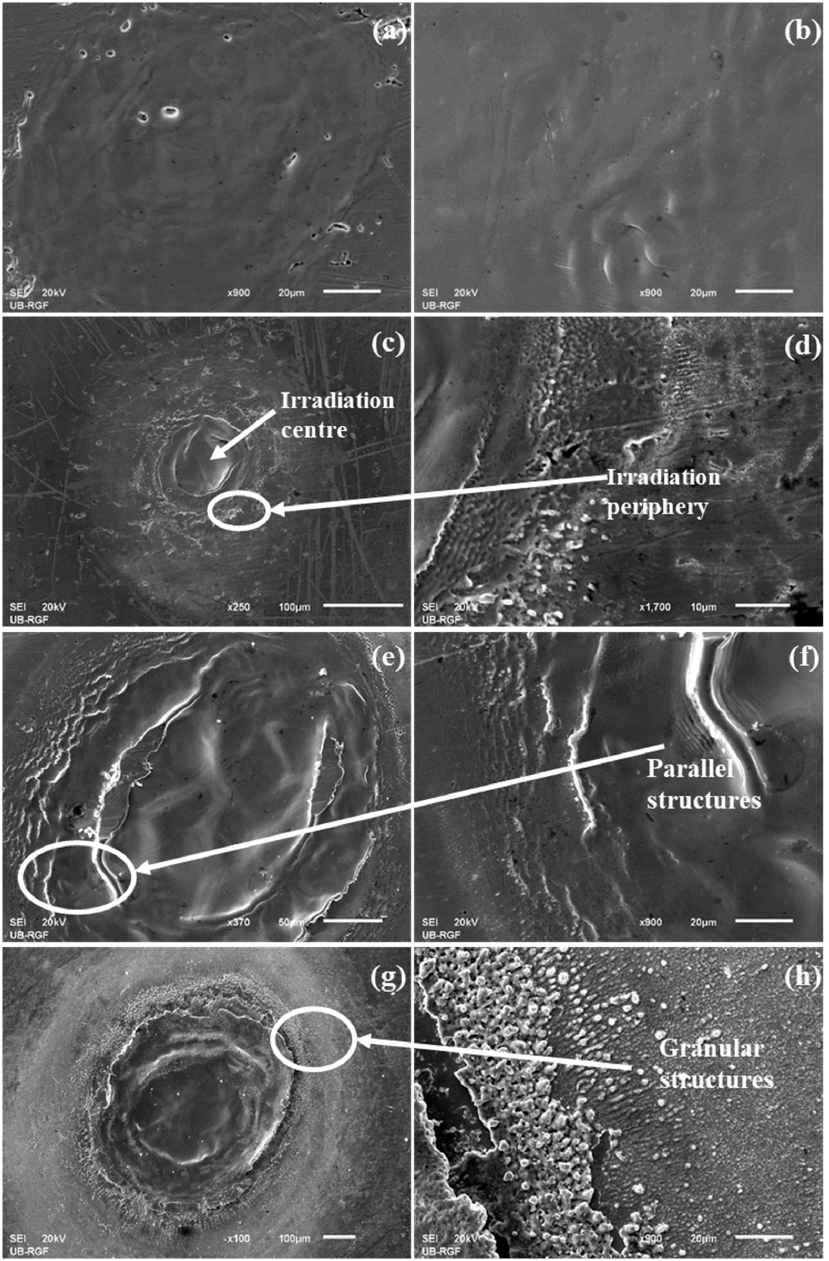
Figure 1. SEM microphotographs of Nimonic 263 superalloy surface after the irradiation by pico- second Nd:YAG laser, wavelength 1064 nm, pulse duration 150 ps: ( a ) whole spot and ( b ) periphery, N p = 10, F = 5.50 J cm − 2 , SA conditions; ( c ) whole spot and ( d ) periphery, N p = 100, F = 5.50 J cm − 2 , SA conditions; ( e ) whole spot and ( f ) periphery, N p = 1000, F = 15.1 J cm − 2 , AA conditions; ( g ) whole spot and ( h ) periphery, N p = 1000, F = 19.1 J cm − 2 , NA conditions.